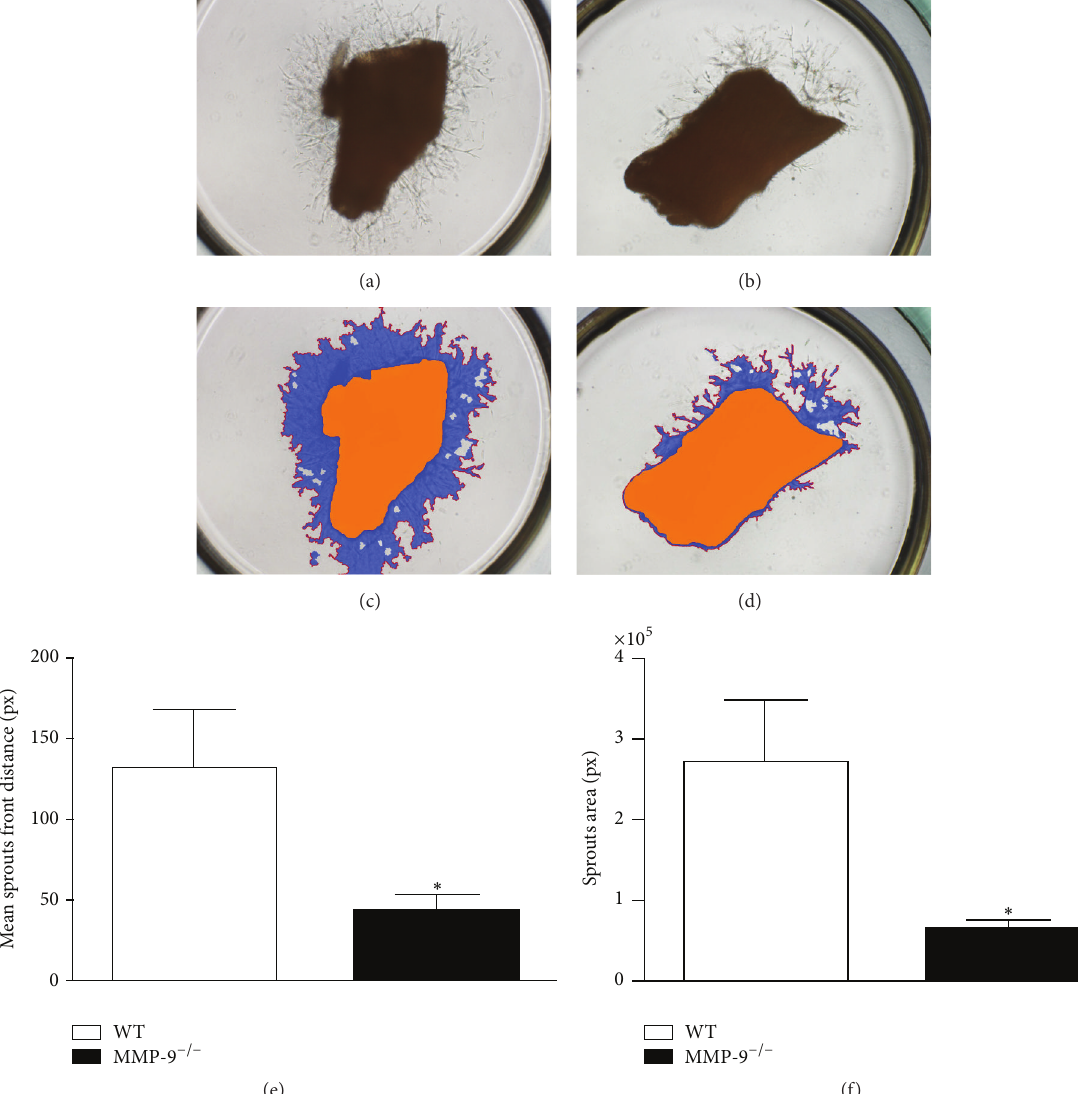
Figure 1: In vitro studies for quantification of angiogenesis ability in (a–d) illustrating the results of aortic ring culture in wild-type (WT) (a, c) and MMP-9 −/− (b, d) mice, respectively. (e) Analytical result of mean distance of sprouts. (f) Analytical result of mean sprout area. ∗ indicates 𝑝 < 0.0001 between MMP9 −/− group and WT group. 𝑛 = 6 for each